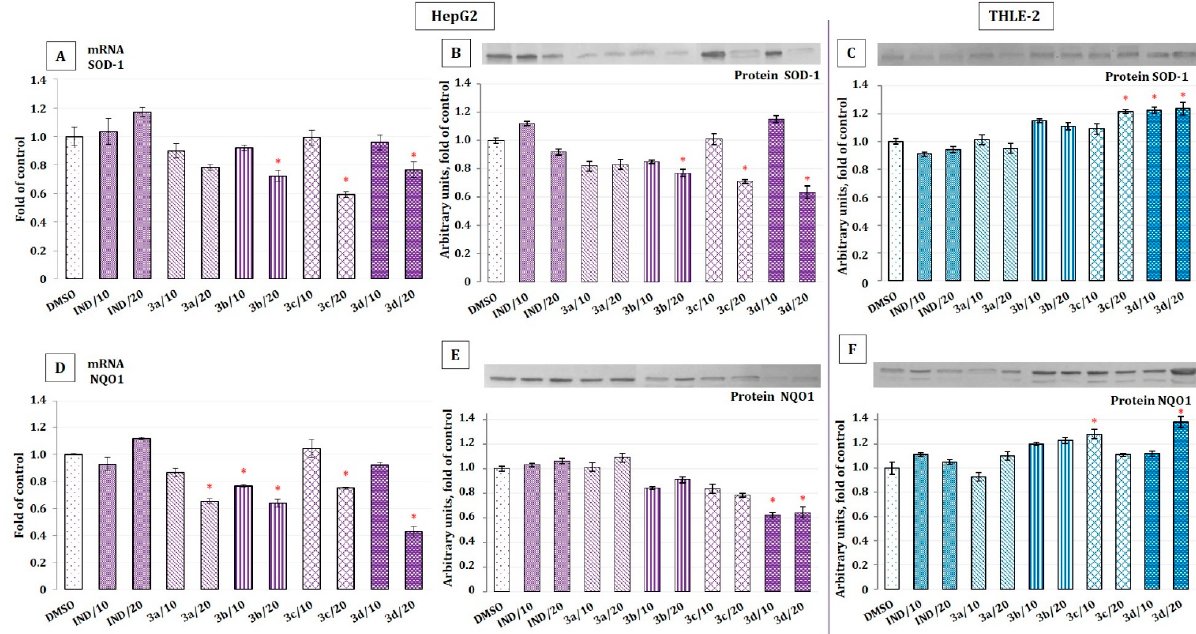
Figure 3. The effect of IND and OAO–IND derivatives ( 3a, 3b, 3c, and 3d ) on SOD-1 ( panels A–C ) and NQO1 ( panels D – F ) mRNA and protein level in HepG2 and THLE-2 cells. The values (means ± SEM) for the mRNA ( panels A,D ) levels were calculated from three separate experiments in comparison with control cells (expression equals 1). Representative immunoblots of the cytosolic content of SOD-1 and NQO1 in HepG2 ( panels B,E ) and THLE-2 cells ( panels C,F ) from three separate experiments are shown. The sequence of the bands corresponds to the sequence of the bars in the graph. The values (means ± SEM) were calculated as protein level in comparison with control cells (expression equals 1). * Significantly different from DMSO (control)-treated cells, p < 0.05.